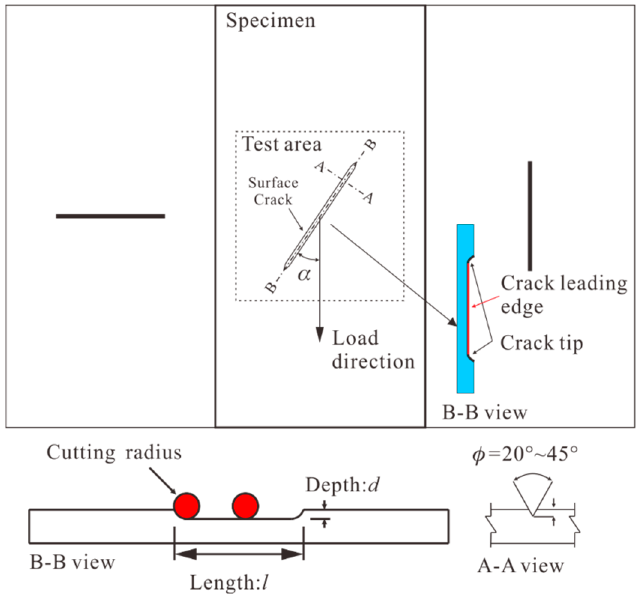
Figure 3. The schematic diagram of the prefabricated crack.